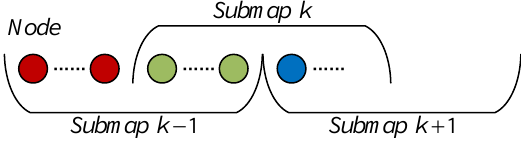
Figure 4. Schematic diagram of submaps and nodes.